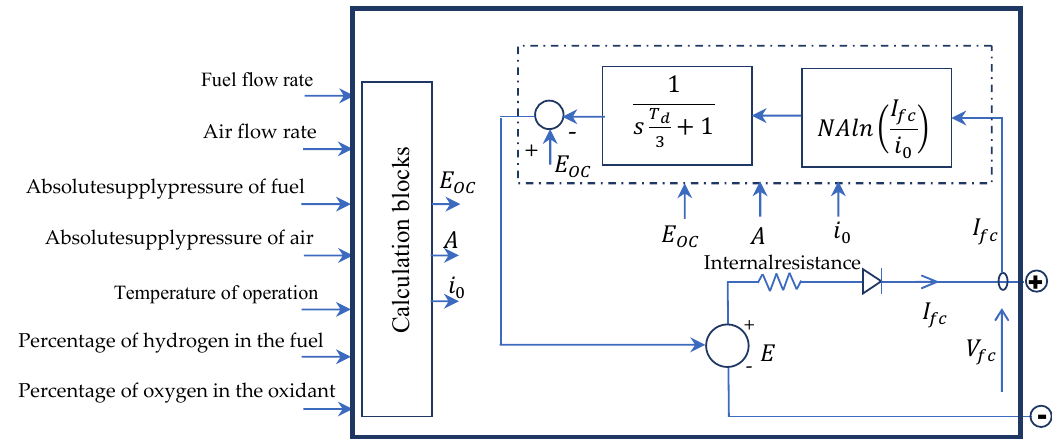
Figure 3. Circuit of the generic model of a fuel cell stack.